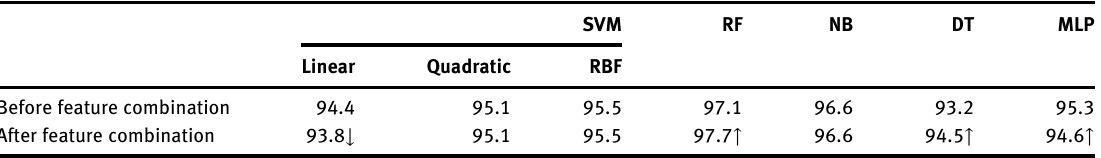
Table  : Algorithms ’ performance before and after the combination of the feature groups. SVM RF NB DT MLP Linear Quadratic RBF  .   .   .  After feature